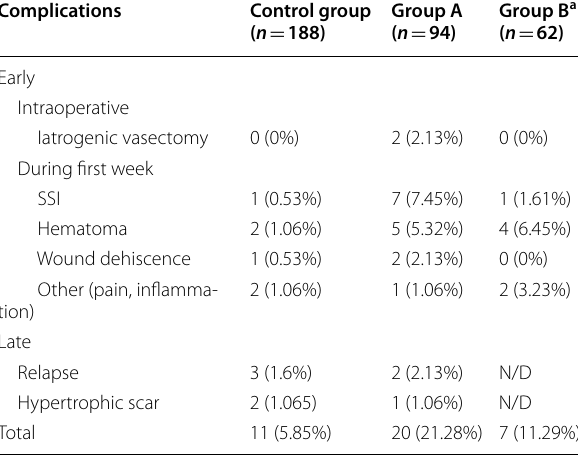
Table 2 Complication incidence distributed between study